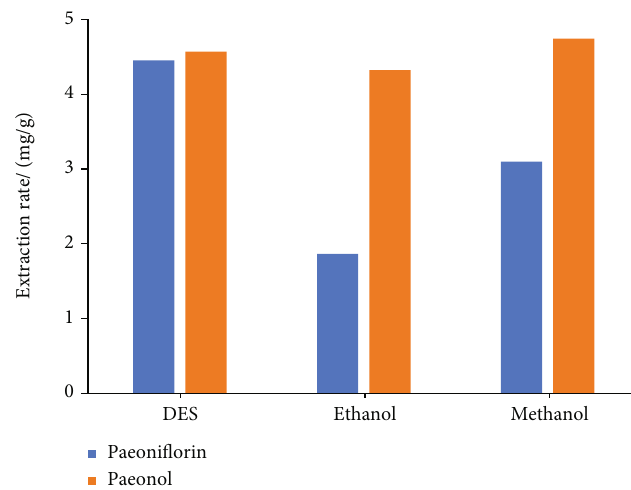
Figure 10: Comparison of di ff erent extraction